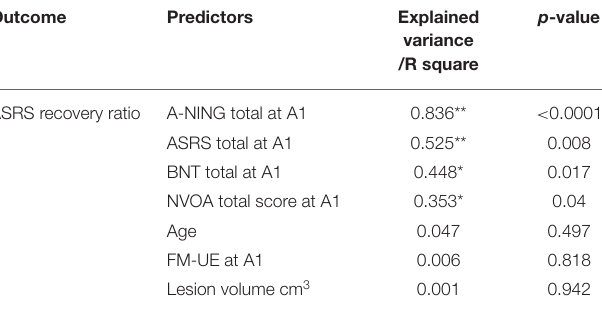
TABLE 7 | Univariate linear regression analyses ( n = 15).